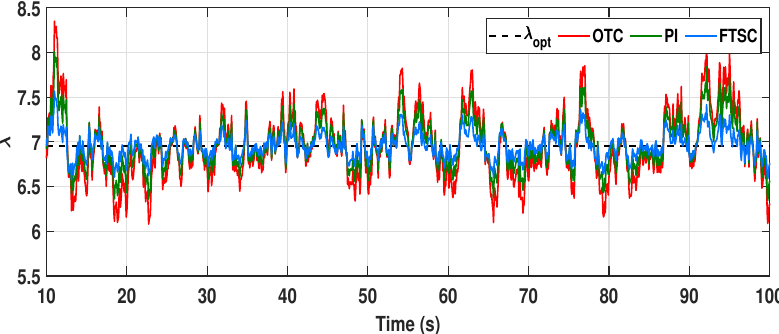
Figure 13. Comparative evaluation of tip speed ratio ( λ ) for varying wind profile case-I